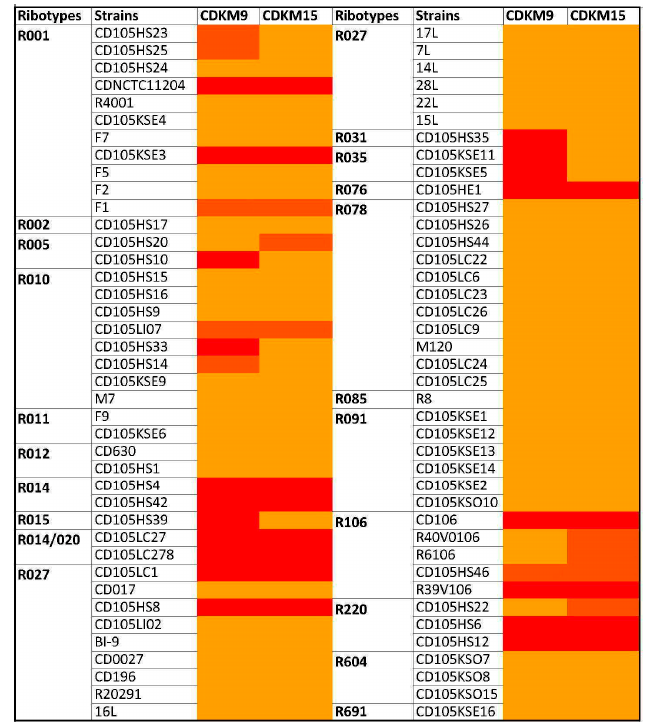
Figure 2. Heat map representation of lysis profiles of CDKM9 and CDKM15 for 80 Clostridium difficile strains. Colours indicate different phage infection parameters observed in the spot tests: red is clearing of the lawn, orange is clearing with turbidity and yellow was no clearing.